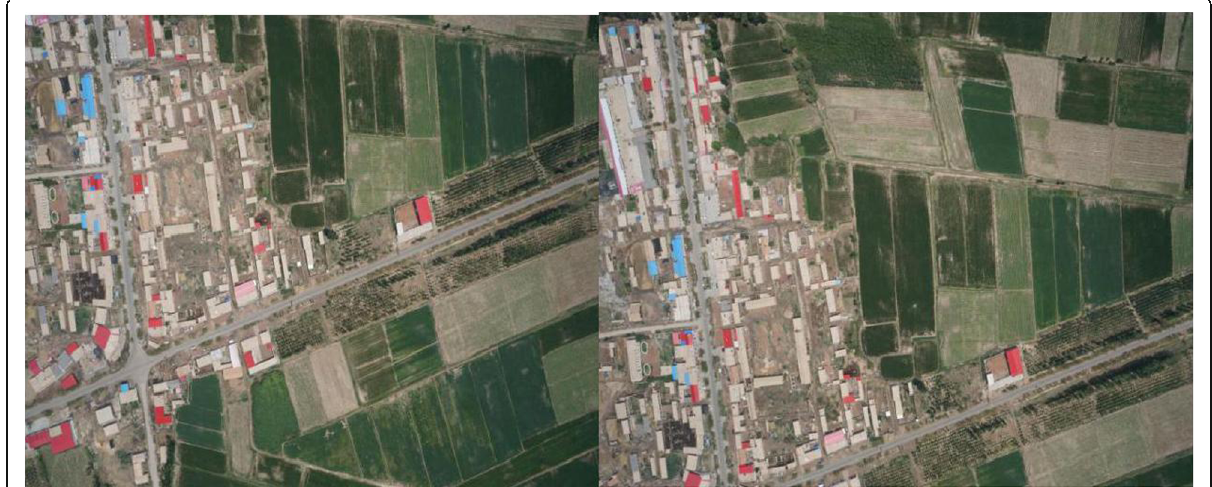
Fig. 2 One set of adjacent original images to be